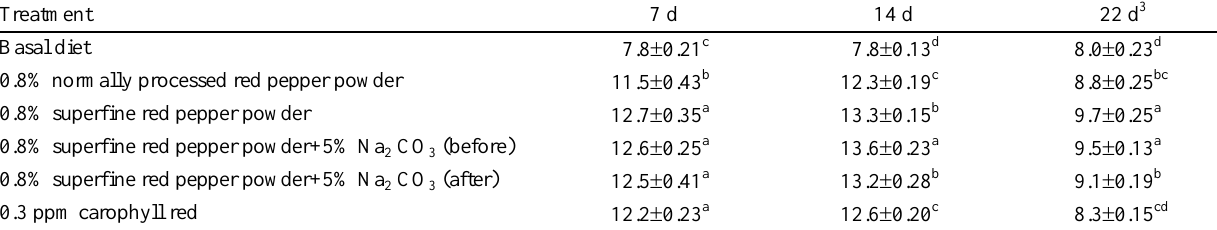
Table 5. Effect of red pepper powder on the egg yolk color scores of laying hens (Exp. 2) 1, 2 Treatment